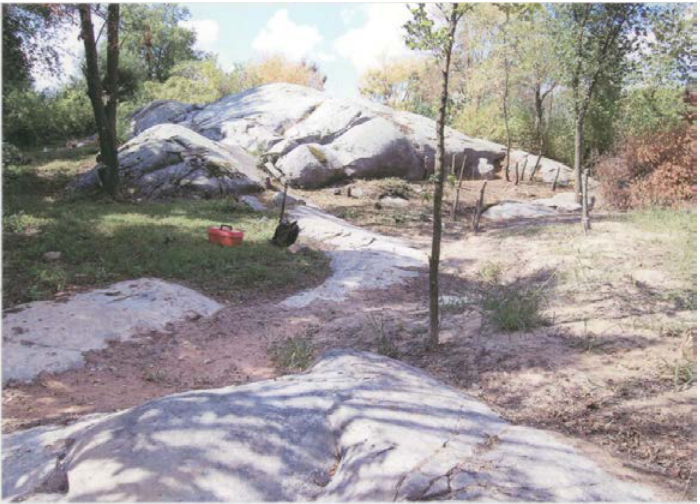
Figure 1. The Hensler Petroglyph Site (47 DO 461) as viewed from the north. Engravings are on the schist seam to left of center on the dome.